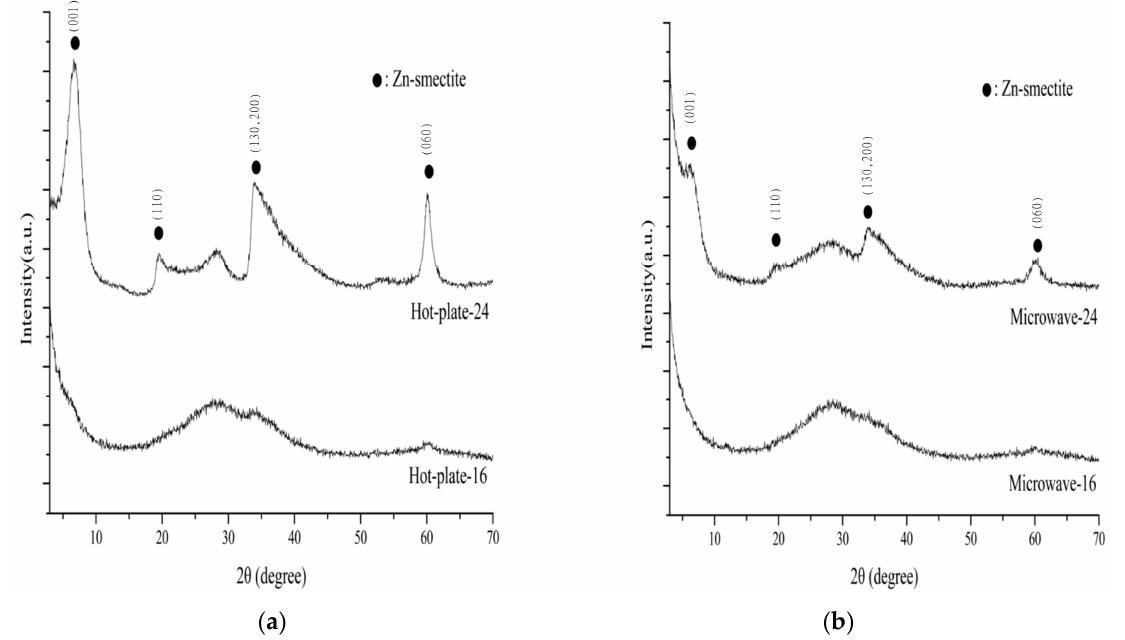
Figure 2. XRD pattern of products synthesized using a hot-plate under atmospheric pressure ( a ) and by using the microwave reflex method ( b ).